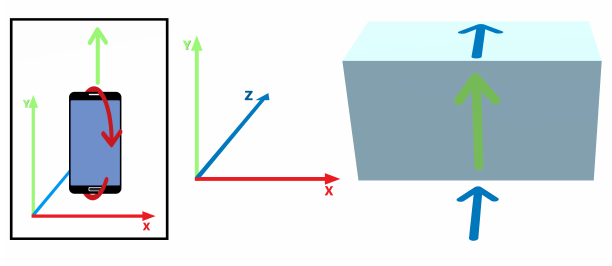
Figure 5. Mobile device motion constrained to 2DOF